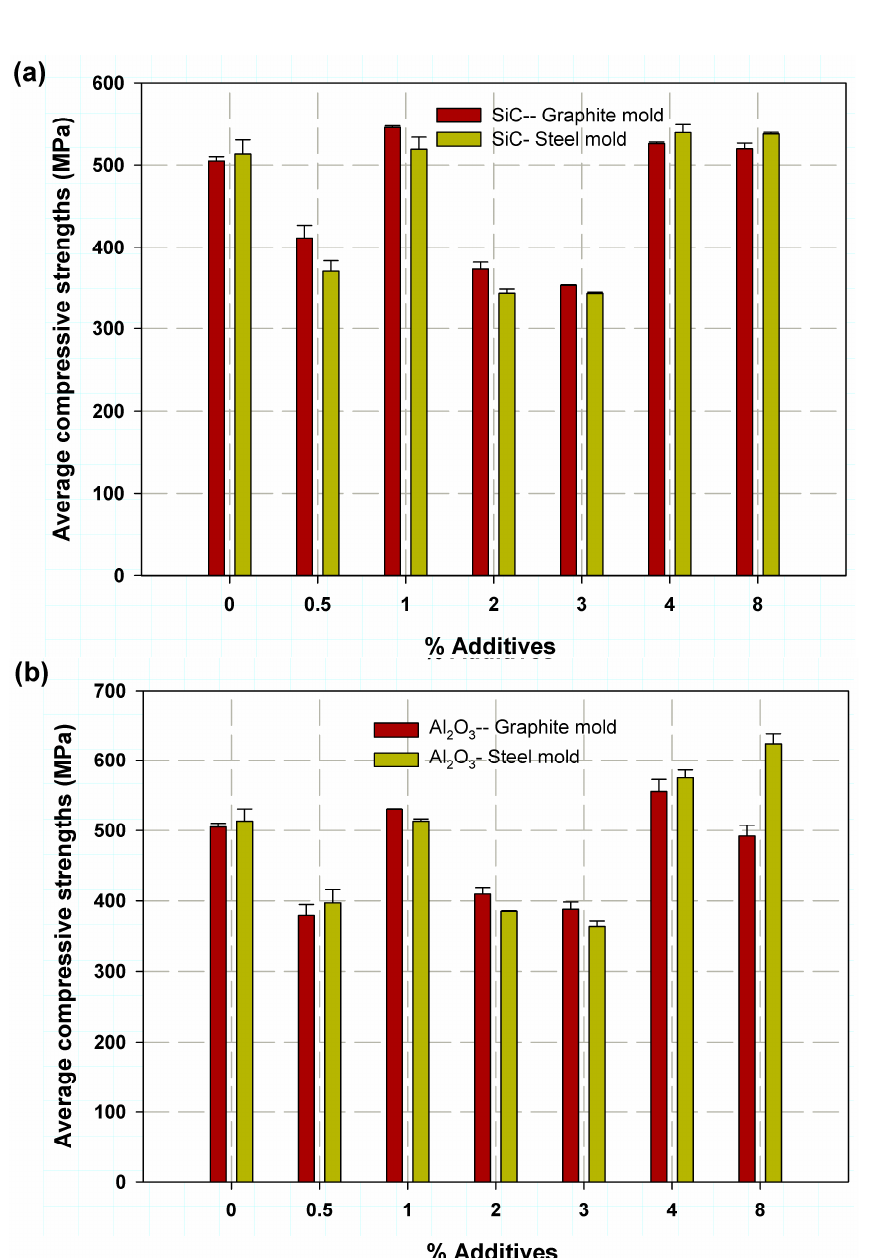
Figure 7. Average stress variation for the Al ‐ Si ‐ Mg alloy filled with ( a ) SiC and ( b ) Al 2 O 3 particles.